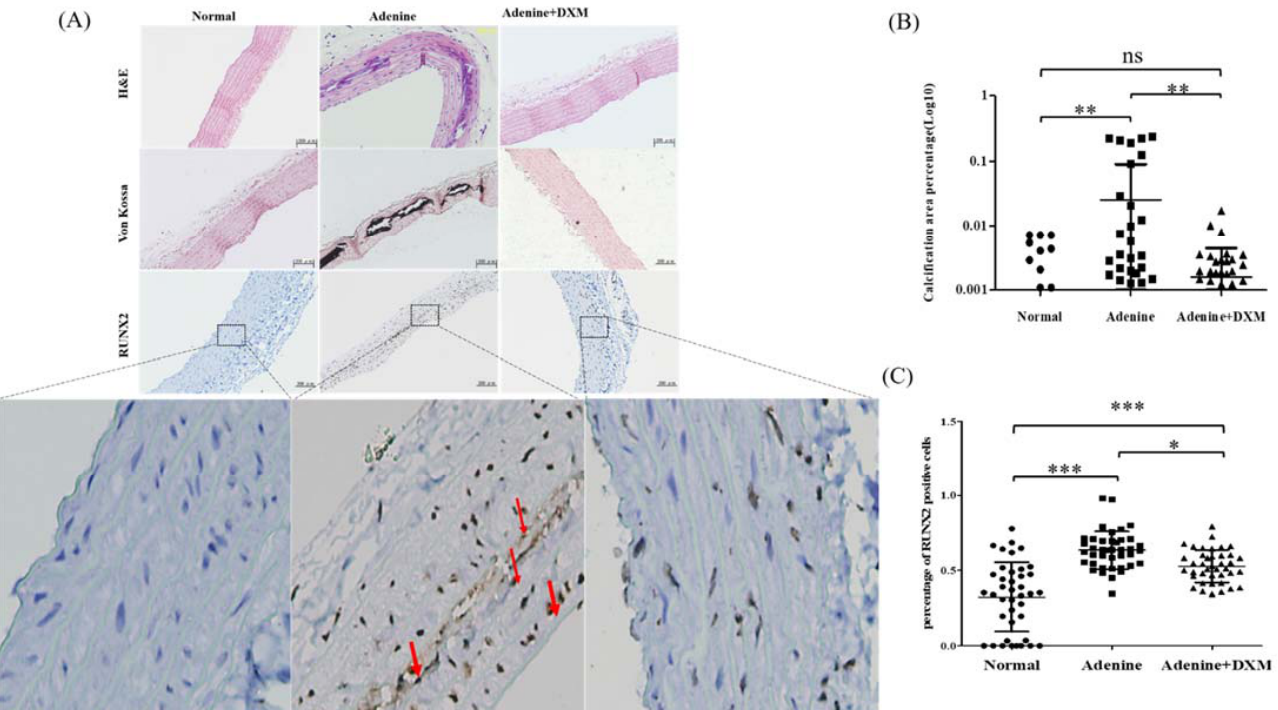
Figure 6. Effects of DXM on the aorta of adenine-induced chronic renal failure rats (n = 8). ( A ) Hematoxylin–eosin staining of the aortas (magnification, ×100). The von Kossa staining of aortas (magnification, ×100). Immunohistochemistry staining with antibody against runt-related transcription factor 2 (RUNX2; magnification, ×100). ( B ) Analysis of aorta calcification in each group. Not significant: ns, ** p < 0.01. ( C ) Analysis of percentage of RUNX2 positive staining cells in the aorta. Not significant: ns, * p < 0.05, ** p < 0.01, *** p <